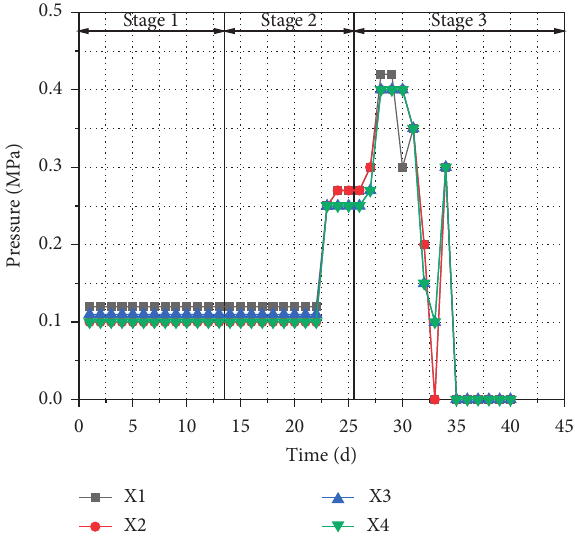
Figure 14: Correlation between the pressure of the pressure relief hole and freezing